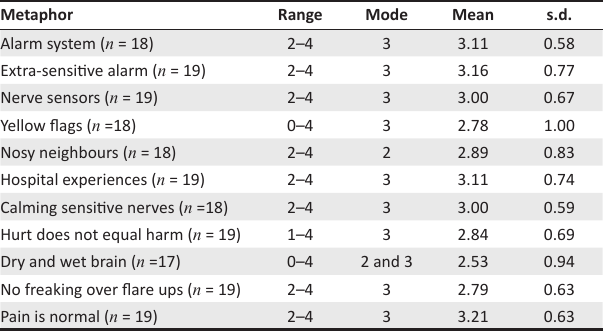
TABLE 3: Individual metaphor information.